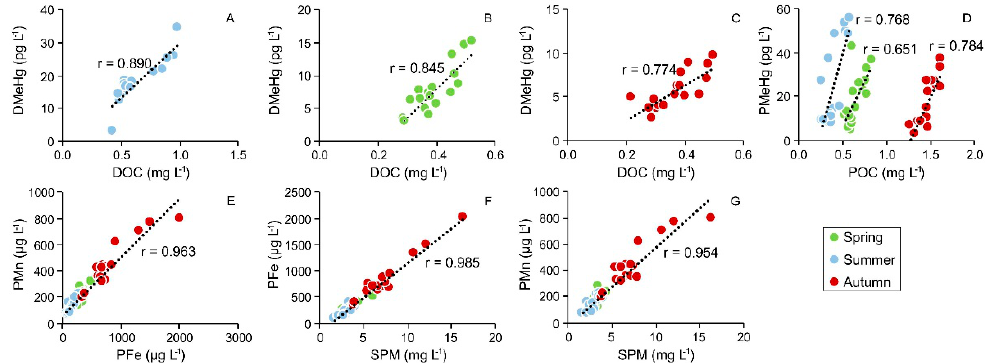
Figure 6. Relationships between DMeHg and DOC ( A – C ), between PMeHg and POC ( D ), between PMn and PFe ( E ) and between PFe, PMn and SPM ( F , G ) along the water column at the Nalón River estuary under different seasonal conditions (spring, summer and autumn).